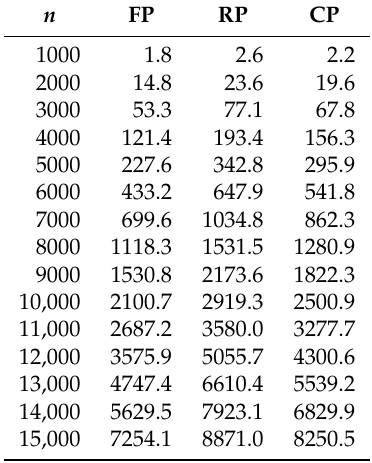
Table 6. Runtimes (s) of index